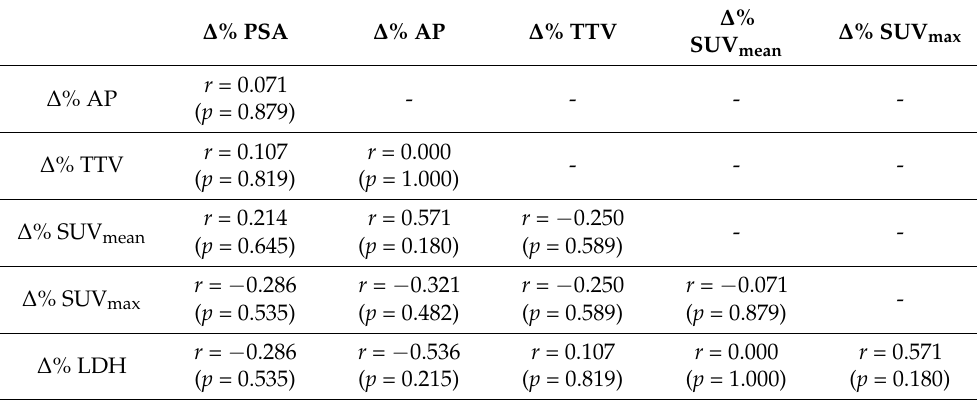
Table 5. Correlation of percental changes of clinical and image-derived parameters after two cycles of 225 Ac-PSMA-I&T. ∆ % ∆ % PSA ∆ % AP ∆ % TTV ∆ % SUV max SUV mean ∆ % AP r = 0.071 - - - - ( p = 0.879) r = 0.000 ∆ % TTV r = 0.107 - - - ( p = 0.819) ( p = 1.000) r = 0.214 r = 0.571 r = − 0.250 ∆ % SUV - - mean ( p = 0.645) ( p = 0.180) ( p = 0.589) r = − 0.286 r = − 0.321 r = − 0.250 r = − 0.071 ∆ % SUV - max ( p = 0.535) ( p = 0.482) ( p = 0.589) ( p = 0.879) − 0.286 r = − 0.536 r = 0.107 r = 0.000 r = 0.571 ∆ % LDH r = ( p = 0.535) ( p = 0.215) ( p = 0.819) ( p = 1.000) ( p =